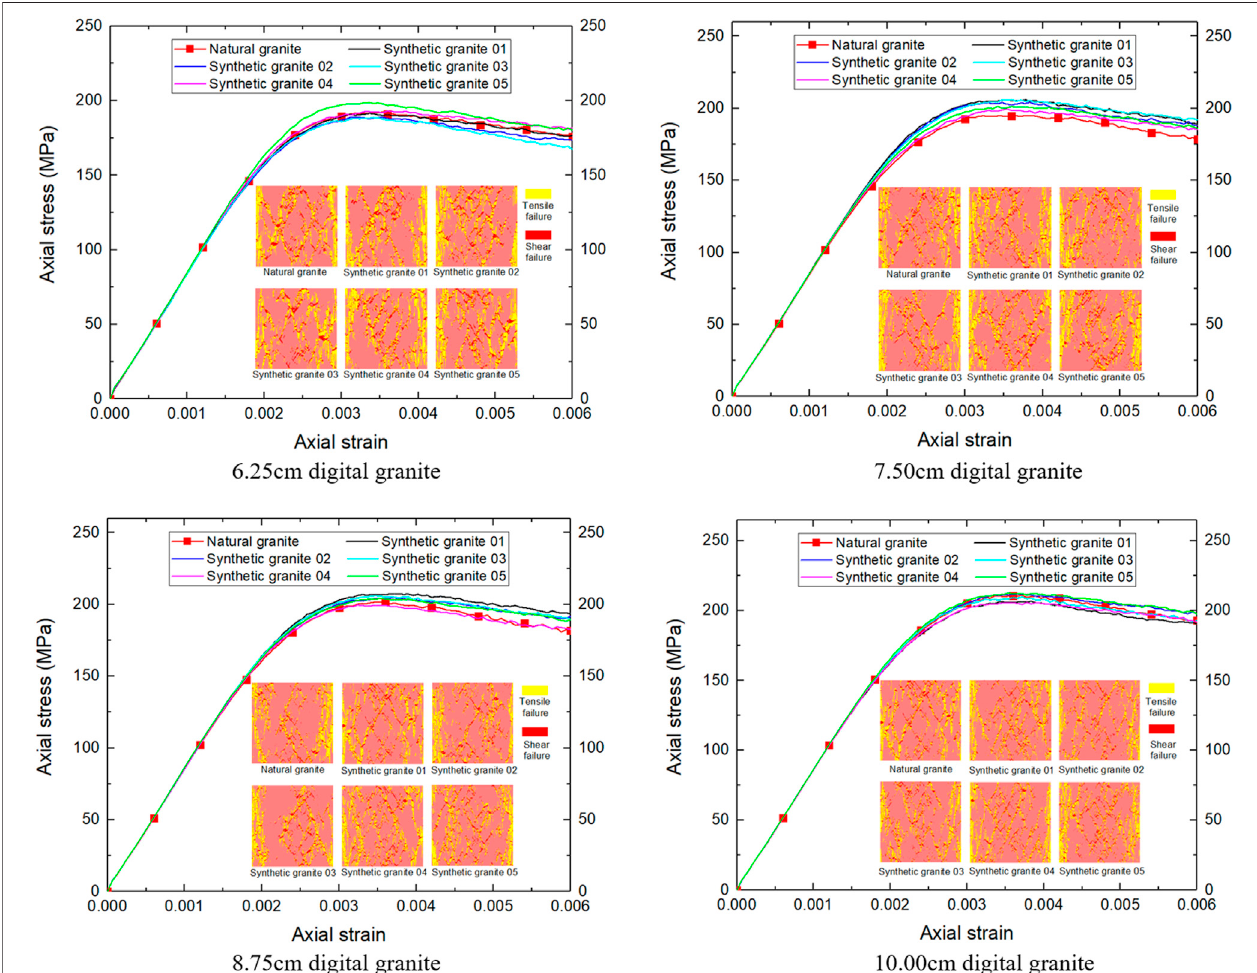
FIGURE 11 | The stress-strain law and failure patterns in multi-scale natural and synthetic granite.